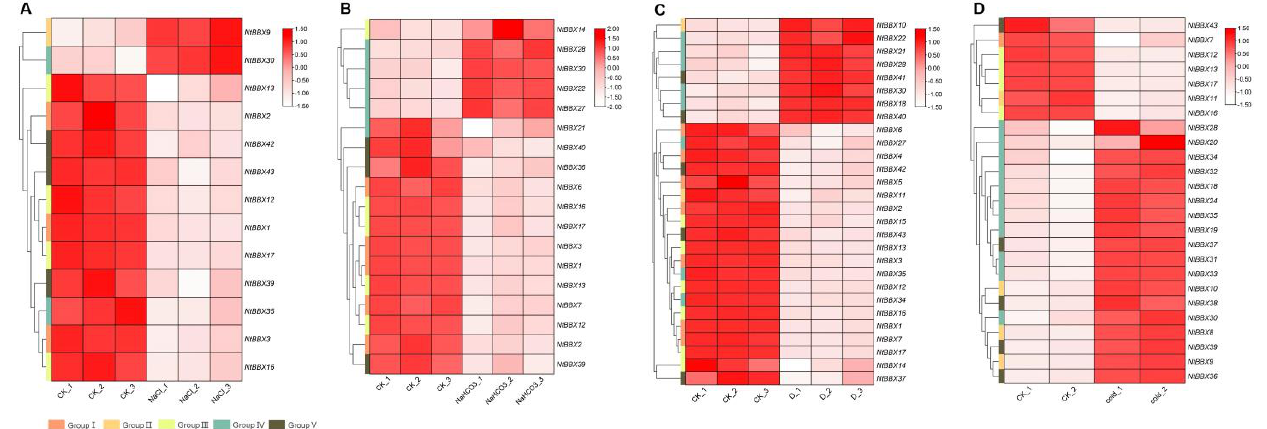
Figure 6. Expression patterns of NtBBX genes under abiotic stress. ( A ) Expression pattern of NtBBX genes under NaCl stress; ( B ) Expression pattern of NtBBX genes under NaHCO 3 stress; ( C ) Expression pattern of NtBBX genes under dehydration stress; ( D ) Expression pattern of NtBBX genes under cold stress. Subgroups Ⅰ–Ⅴ are represented by different colored boxes.